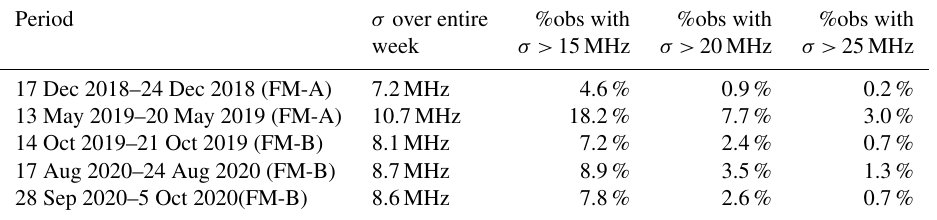
Table 4. Laser frequency stability during different phases of the Aeolus mission. The table provides the standard deviation of the relative frequency at the pulse-to-pulse level (mean over all observations from 1 week) as well as the percentage of observations (%obs) for which σ f (N = 540 ) is above 15, 20 and 25MHz, respectively. FM-A was operating during the first two selected periods, while FM-B was operating in the other 3 weeks. See also the time series of the frequency stability for the week in October 2019 in Fig. 4. Period σ over entire %obs with %obs with %obs with week σ > 15MHz σ > 20MHz σ >